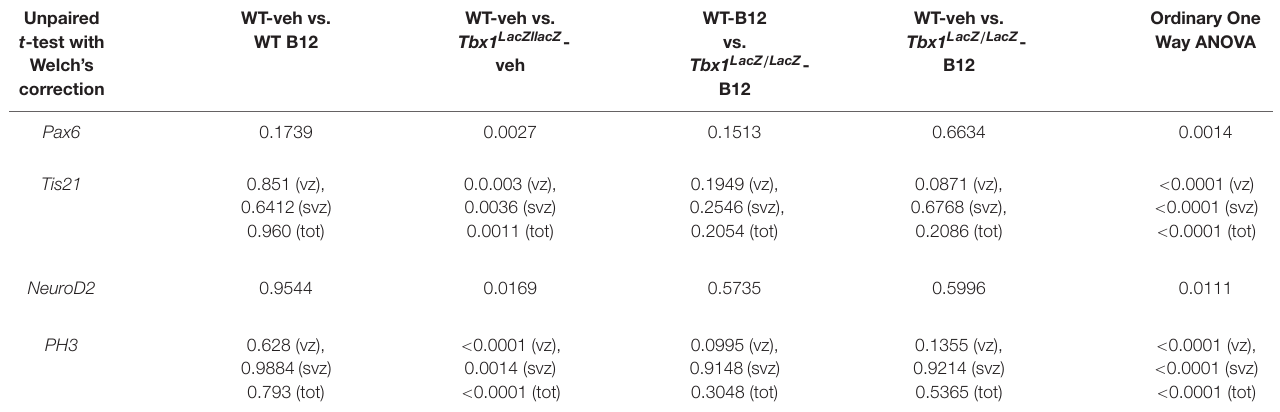
TABLE 3 | P values for the data shown in the graphs (dot-plots) in Figure 5 . Unpaired t -test with Welch’s